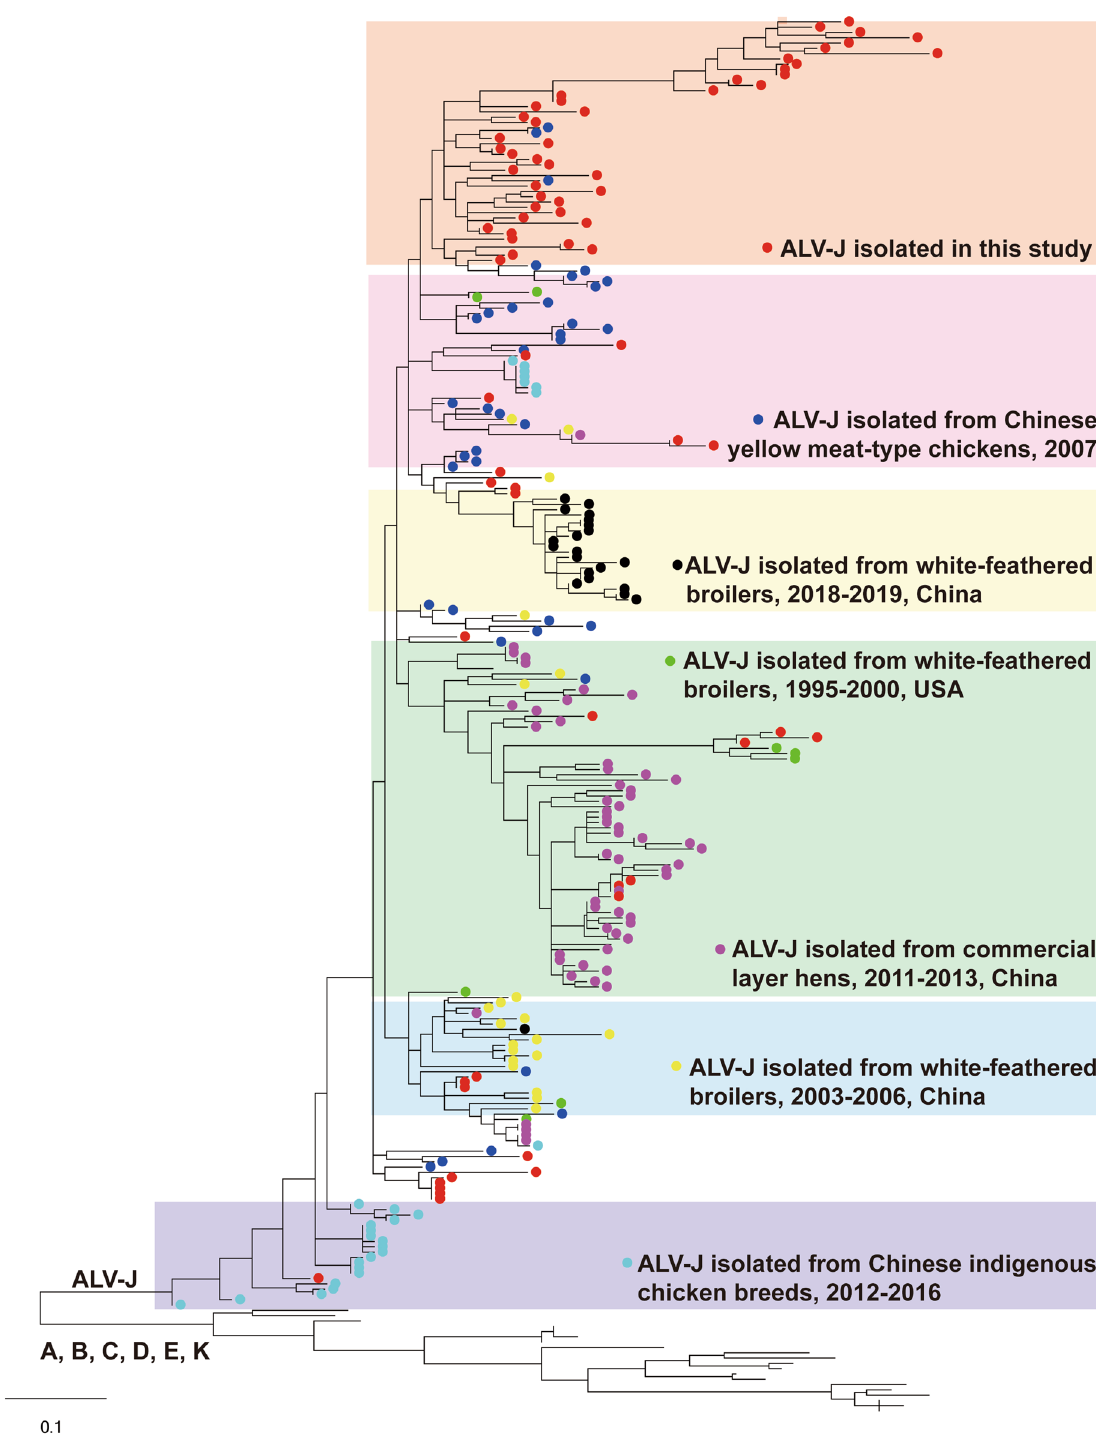
Figure 3. Phylogenetic tree based on the gp85 sequences of 71 ALV strains isolated in this study and 180 reference strains (162 ALV-J strains isolated from different flock and 18 ALV strains in subgroup A, B, C, D, E and J). The tree was constructed by the maximum likelihood method with 1000 bootstrap replicates using MEGA 5.0. The 71 ALV strains isolated in the study are shown with filled red circles, while other strains with different backgrounds are marked with different colored circles (specified in the